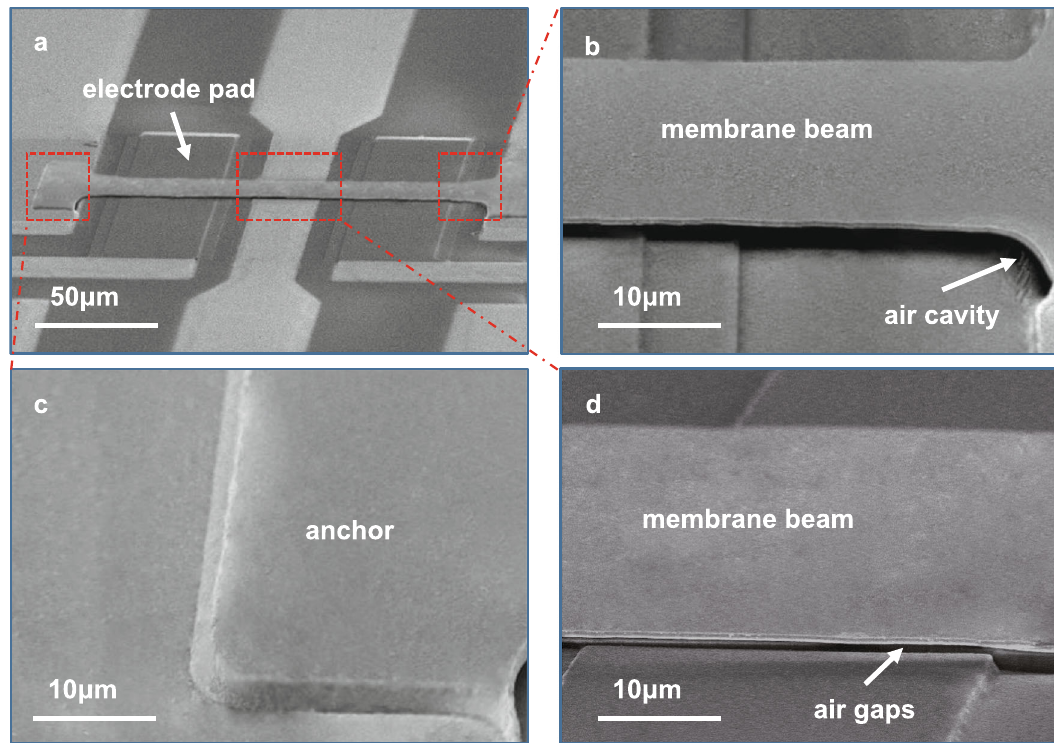
Fig. 4 SEM image of MEMS switch with double-clamped membrane beam. a Overall structure diagram of MEMS switch, ( b ) magni fi ed image showing the free-standing membrane on air cavity at the anchor, ( c ) magni fi ed image showing the anchor structure and ( d ) magni fi ed image showing the membrane beam on the signal transmission line and the air gap between